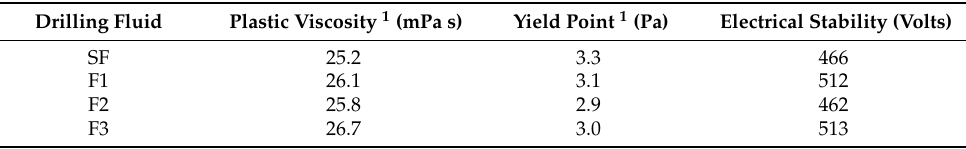
Table 2. Plastic viscosity, yield point, and electrical stability of olefin-based drilling fluids. Drilling